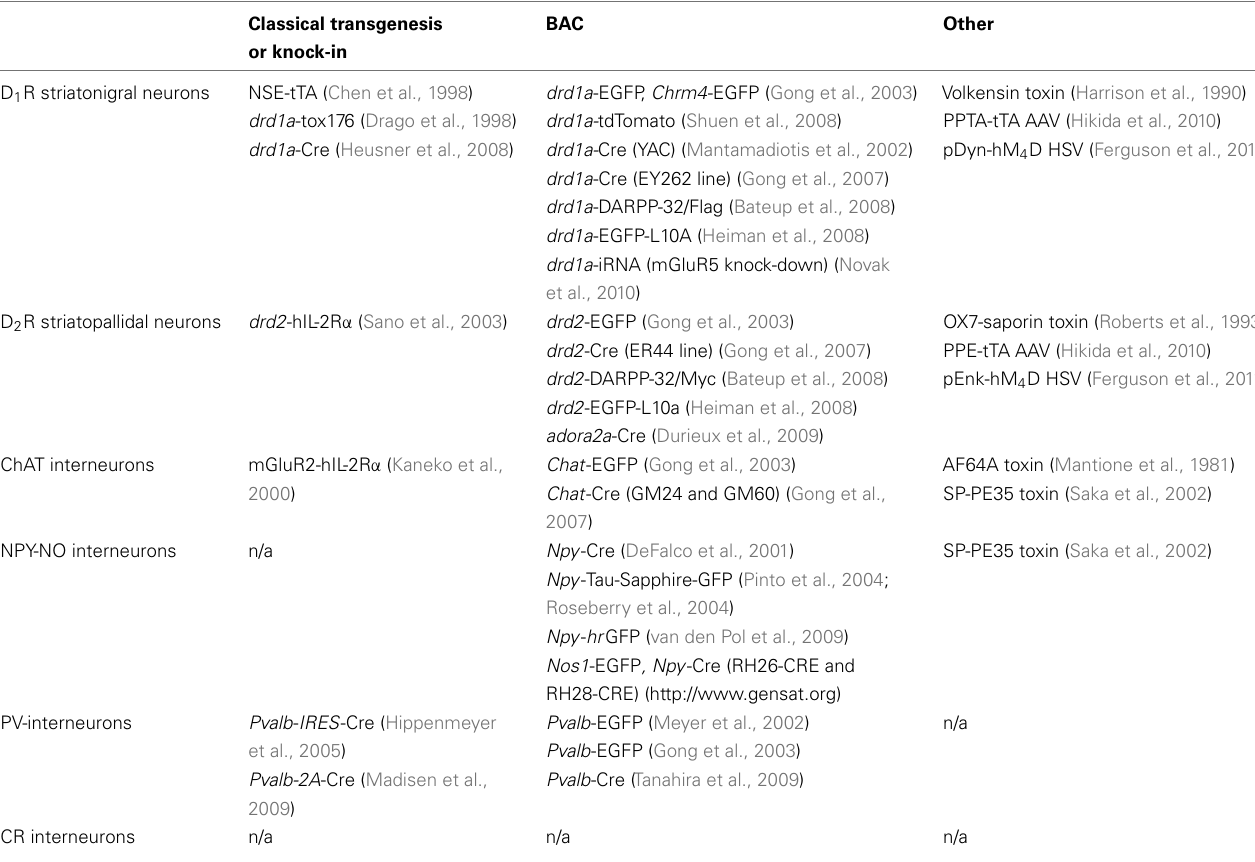
Table 1 | Distinct strategies to target the subpopulations of the striatum. Classical